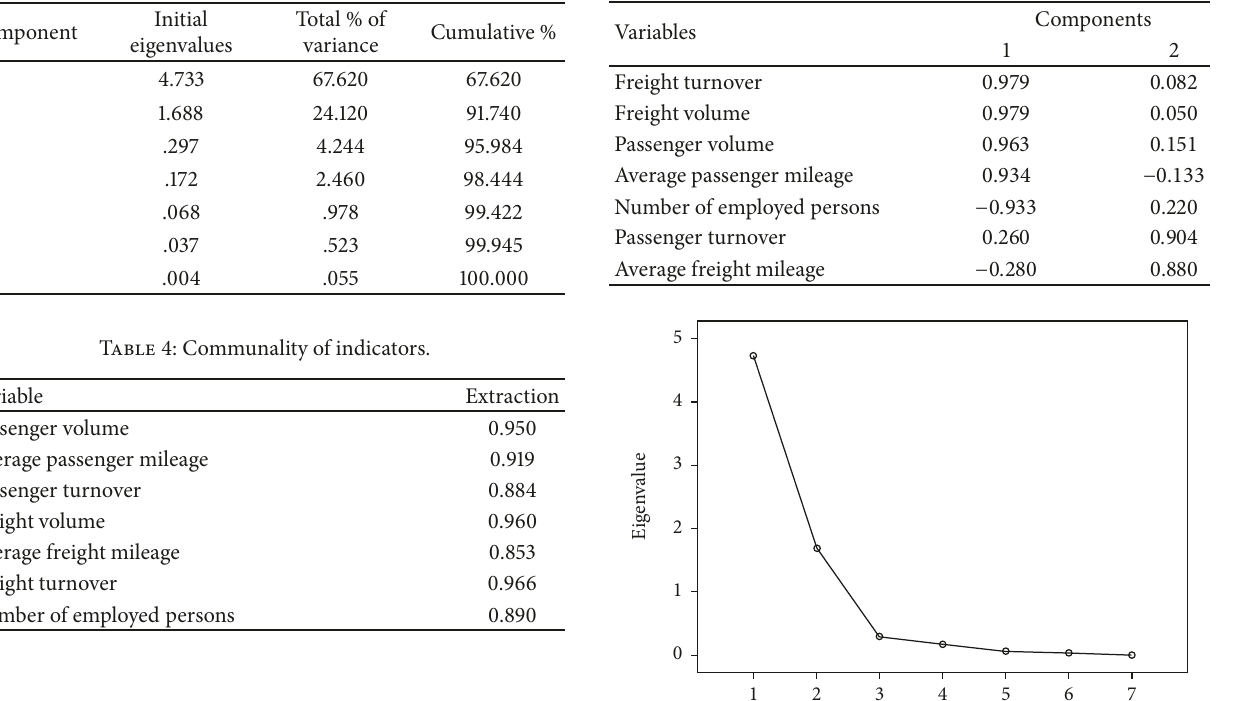
Table 3: Principal component analysis explains total variance.